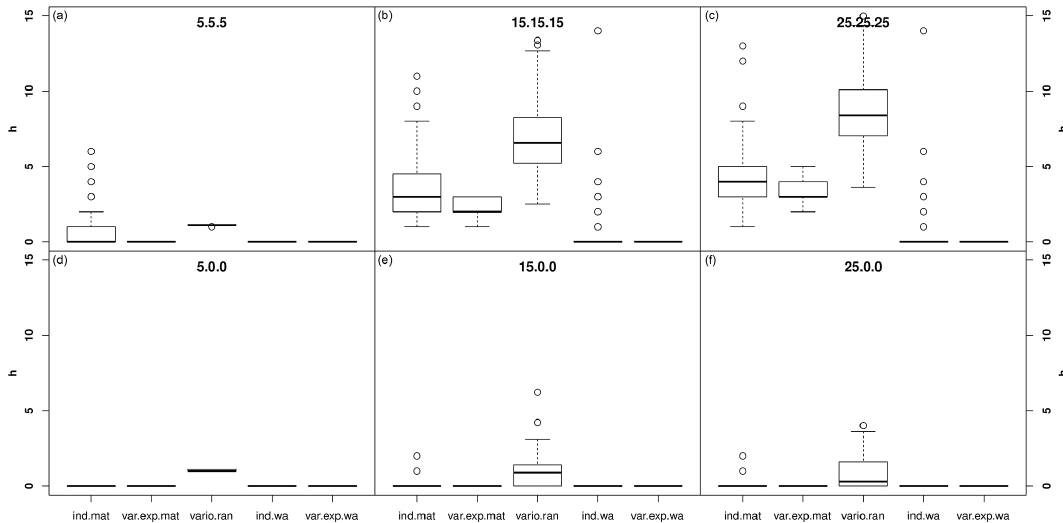
Figure 1. Estimates of h for different levels of autocorrelation in the environmental variables: (a) – (c) equal spatial autocorrelation in the variable of interest and the nuisance variables; (d) – (f) variable of interest with spatial autocorrelation but no spatial autocorrelation in the nuisance variables. Boxplots from left to right show h selected by a spatially independent test set using the modern analogue technique (MAT), the variance-explained method using MAT, the variogram range of weighted averaging (WA) residuals, a spatially independent test set using WA, and the variance-explained method using WA. First number in each panel title gives the range of the variogram used to simulate the environmental variable of interest (5, 15, or 25), while the two latter numbers give the range of the variograms used to simulate the two nuisance